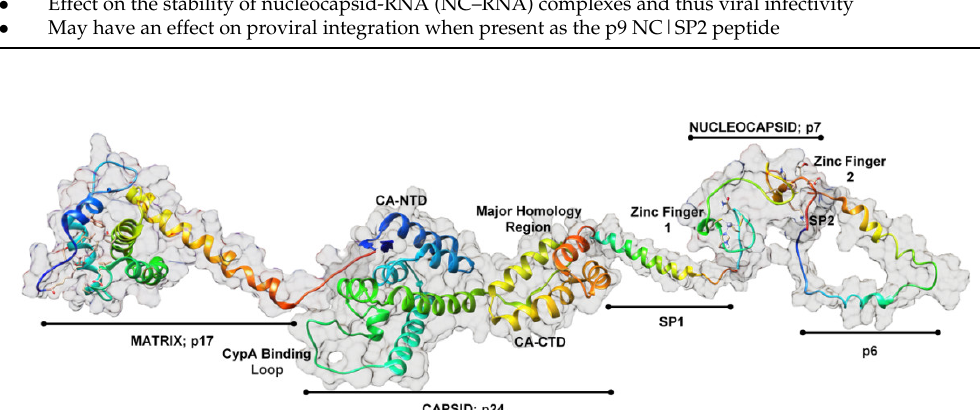
Figure 1. Schematic representation of a rod-shaped HIV-1 Gag polyprotein obtained by the concat- enation of previously resolved structures of individual Gag domains. PDB IDs: matrix (2h3i; [12]); capsid (3nte; [13]); SP1 (1u57; [14]); nucleocapsid (1a1t; [15]); p6 (2c55; [16]). Note: The matrix-capsid linker and SP2 are hypothetical representations.